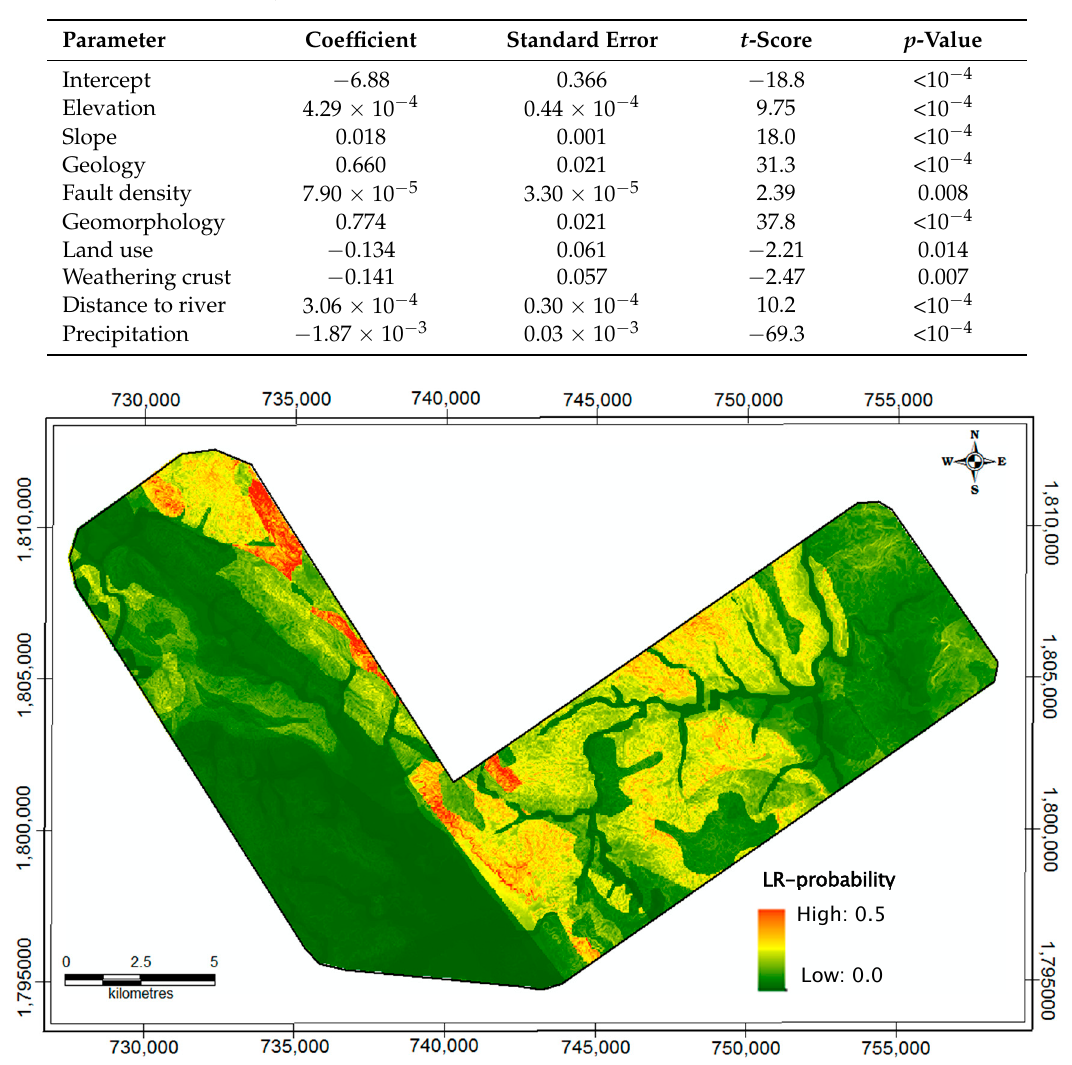
Figure 3. Landslide susceptibility map based on the logistic regression model.